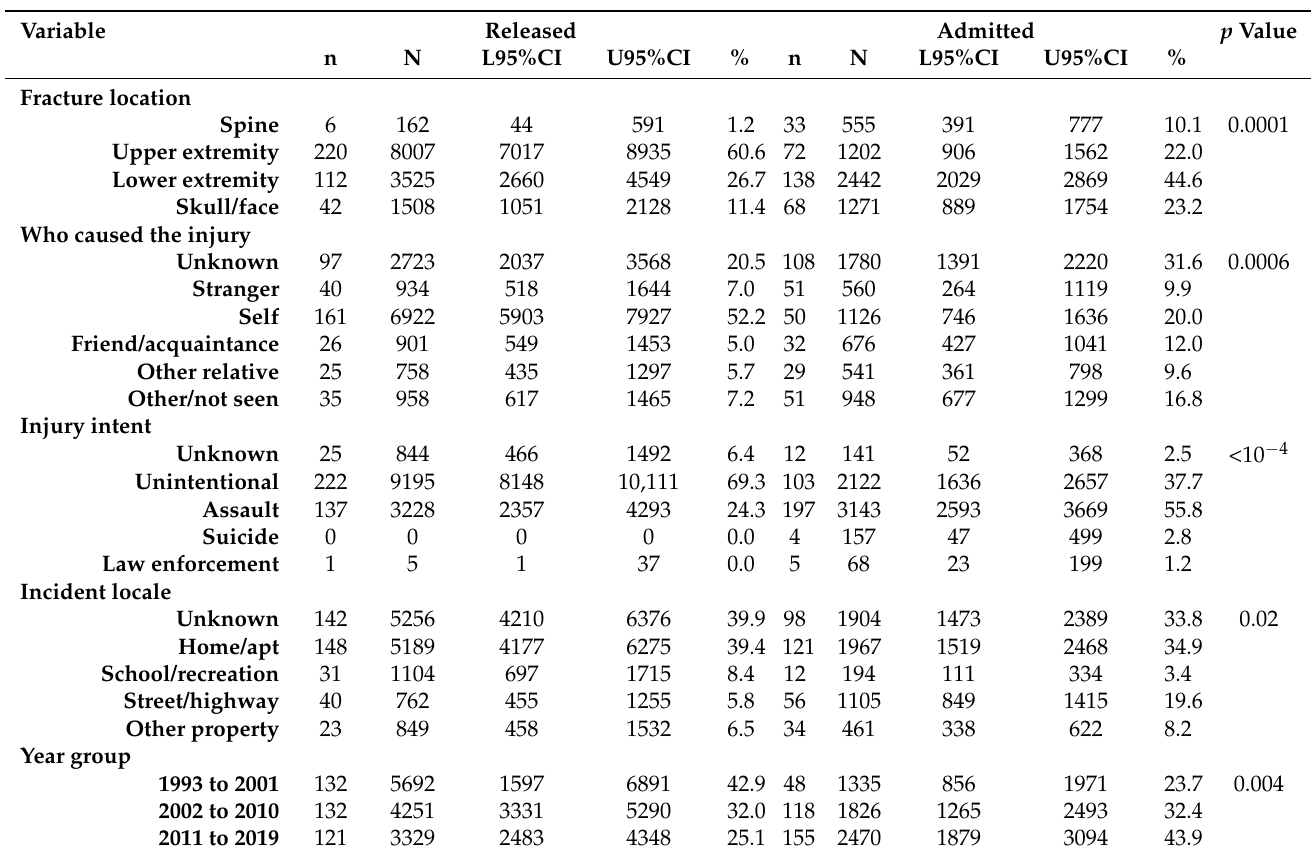
n = actual number, N = estimated number, L95%CI is the lower 95% con fi dence limit for N, U95%CI is the upper con fi dence limit for N.